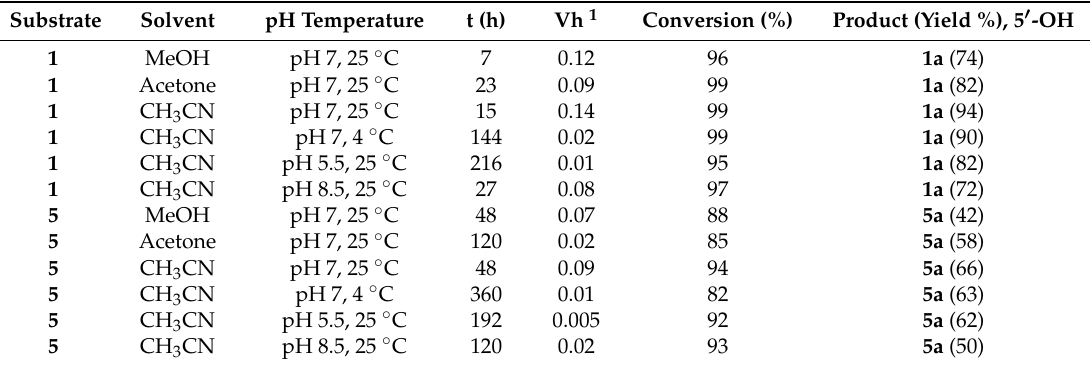
Table 4. Enzymatic hydrolysis of peracetylated nucleosides 1 and 5 catalysed by agarose CNBr-protease N.